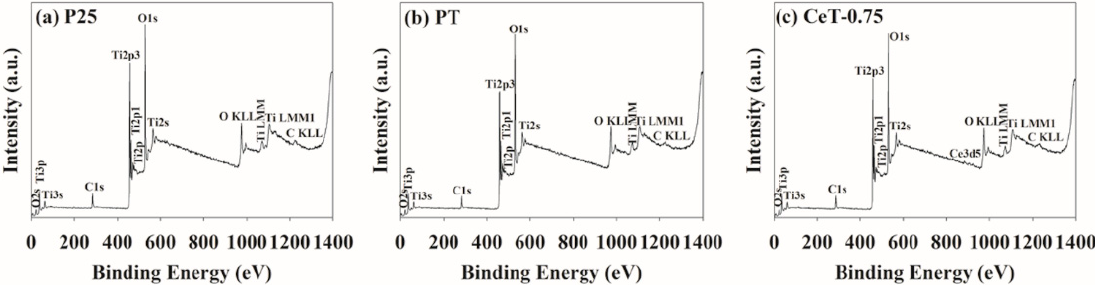
Figure 3. X-ray photoelectron spectroscopy (XPS) profiles of ( a ) Degussa P25 TiO 2 (P25), ( b ) pure TiO 2 (PT), and ( c ) Ce-doped TiO 2 (CeT-0.75).